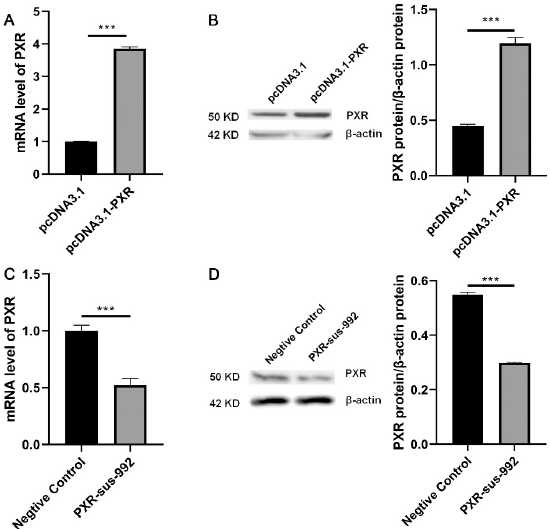
Figure 3. Detection of PXR overexpression and interference efficiency. ( A ) Relative mRNA levels of PXR after pcDNA3.1- PXR transfection into PAM 3D4/21 cells for 36 h. ( B ) pcDNA3.1 or pcDNA3.1- PXR was transfected into PAM 3D4/21 cells. The protein expression of PXR was meas- ured by western blot. ( C ) Relative mRNA level of PXR after PXR -sus-992 transfection into PAM 3D4/21 cells for 36 h. ( D ) Negative control or PXR -sus-992 was transfected into PAM 3D4/21 cells. The protein expression of PXR was measured by western blot. The data are presented as the mean ± SD. The experiment was repeated three independent times. *** p < 0.001.